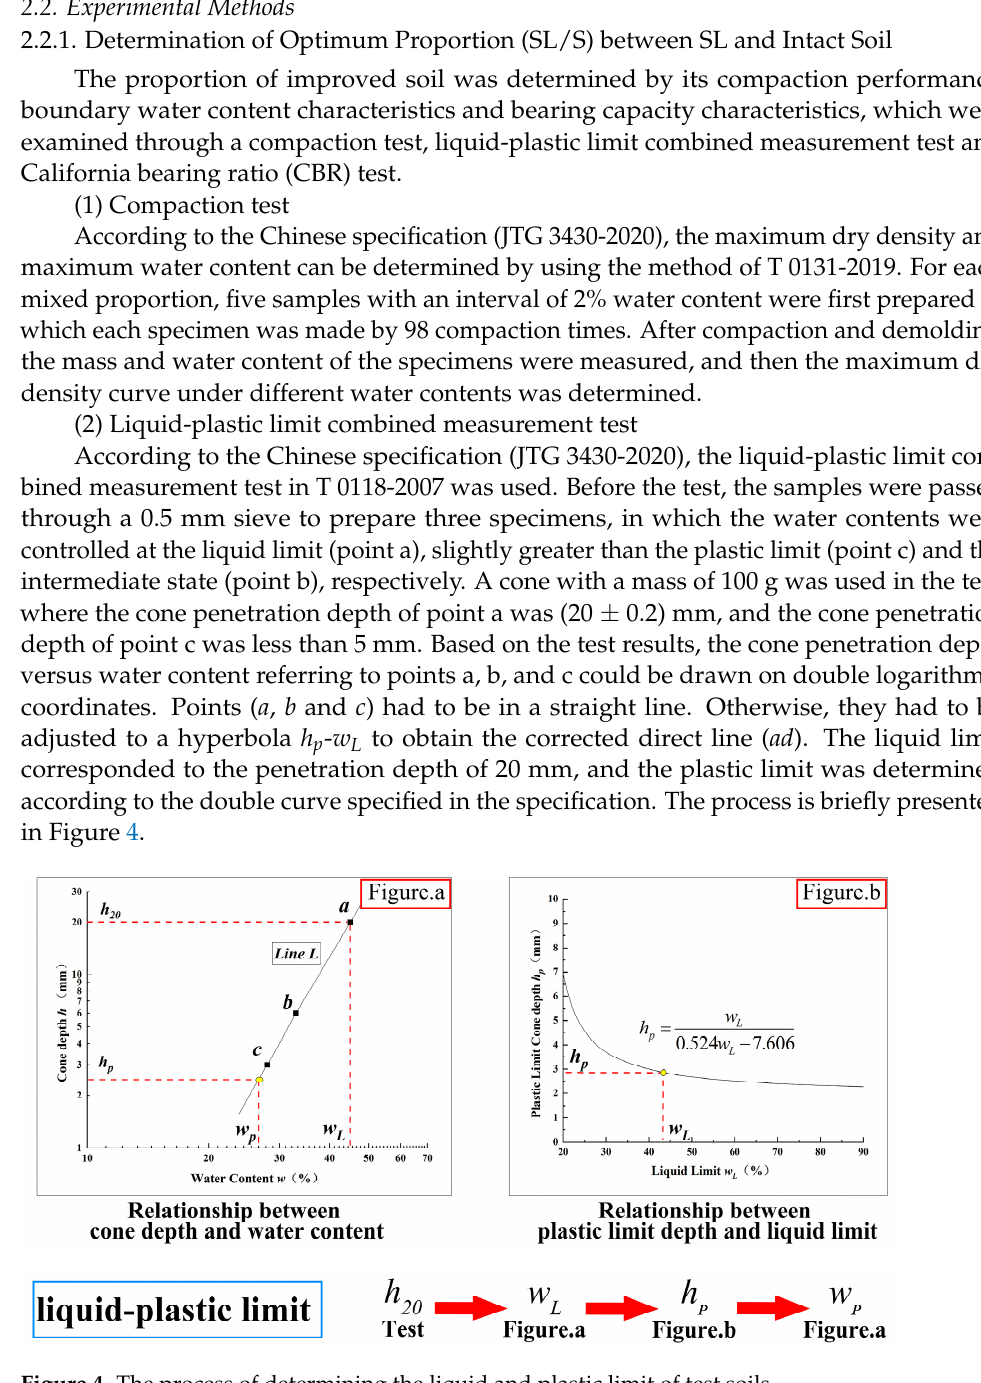
Figure 4. The process of determining the liquid and plastic limit of test soils.